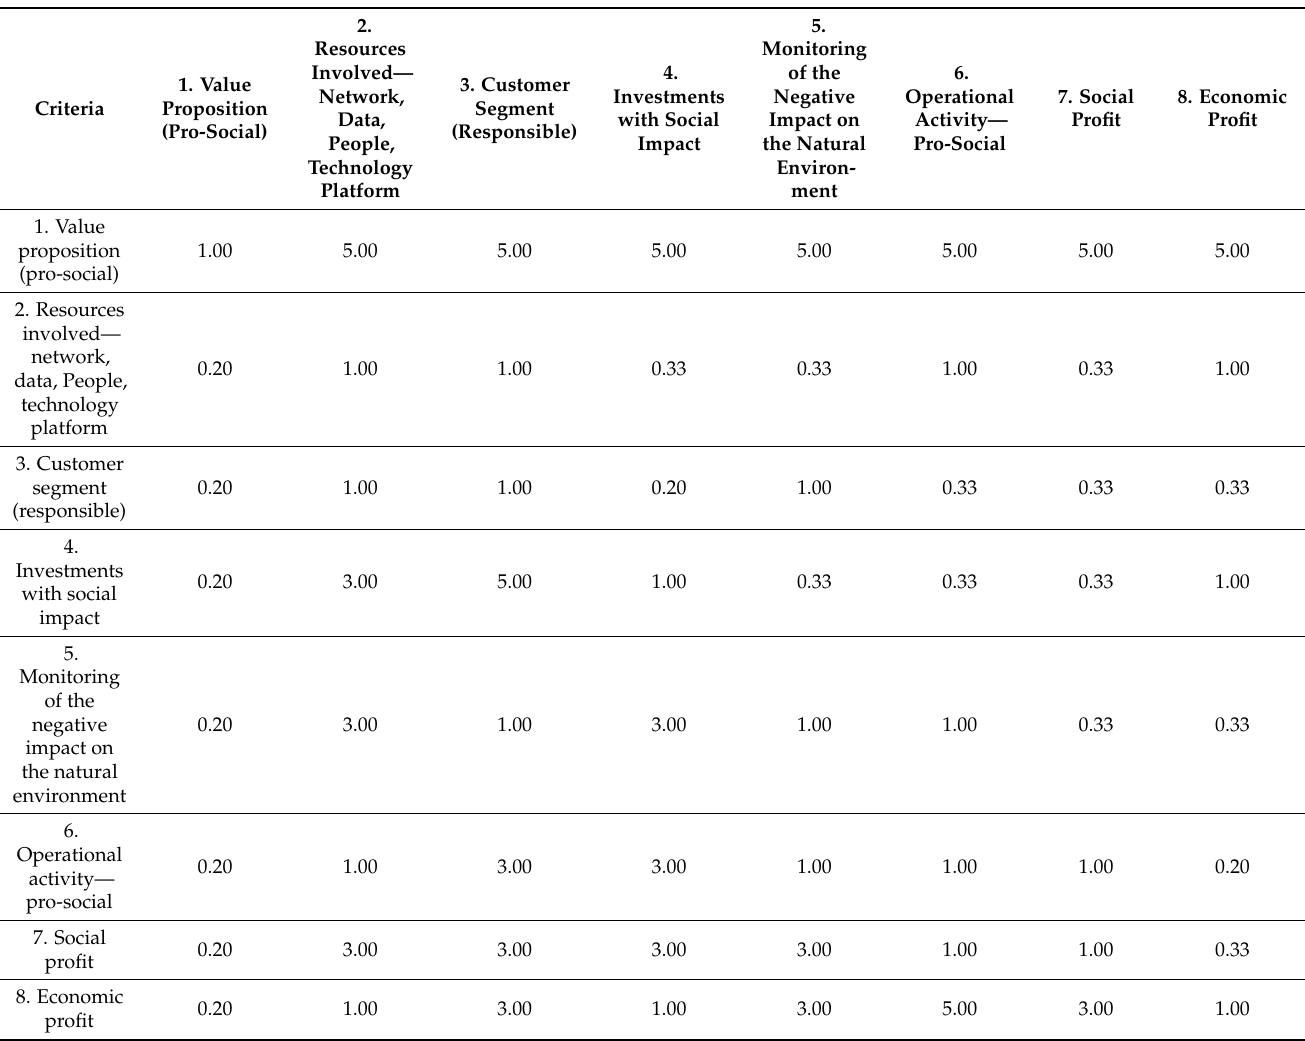
Table 2. Matrix showing the pairwise comparisons for the particular criteria (own